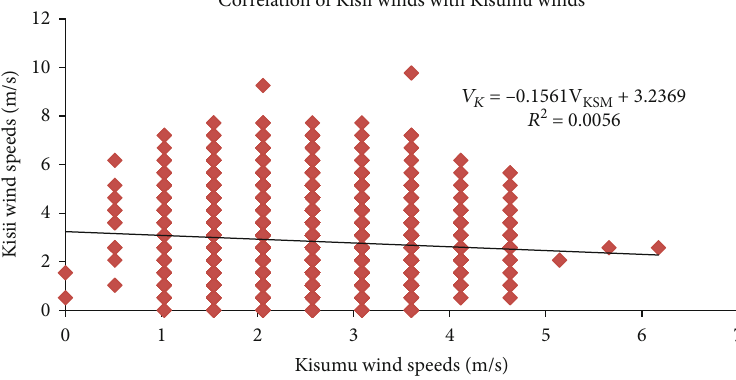
Figure 13: Correlation of Kisii winds with the Kisumu